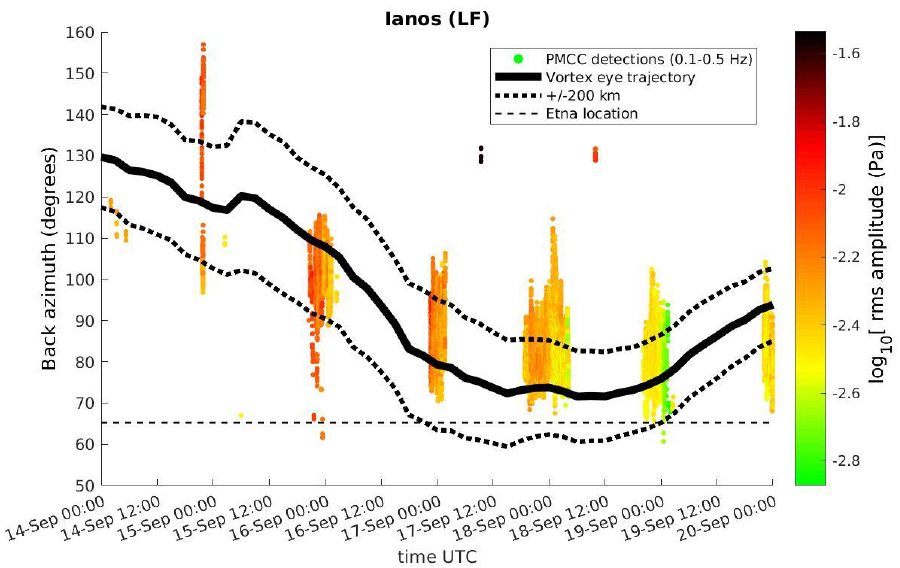
Figure 7. As in Figure 6, but for Ianos.